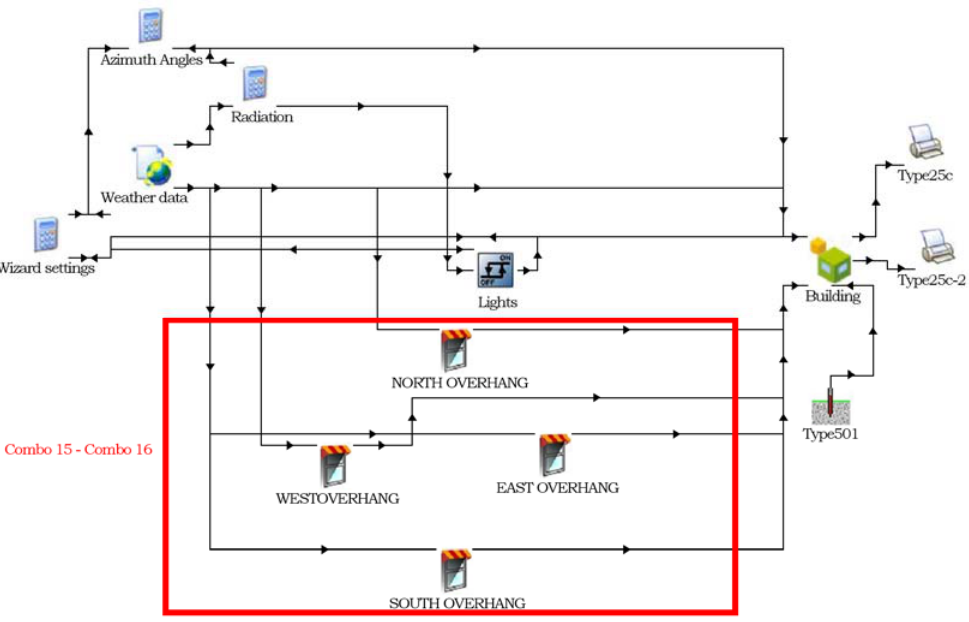
Figure 2. TRNSYS simulation scheme for building energy analysis.